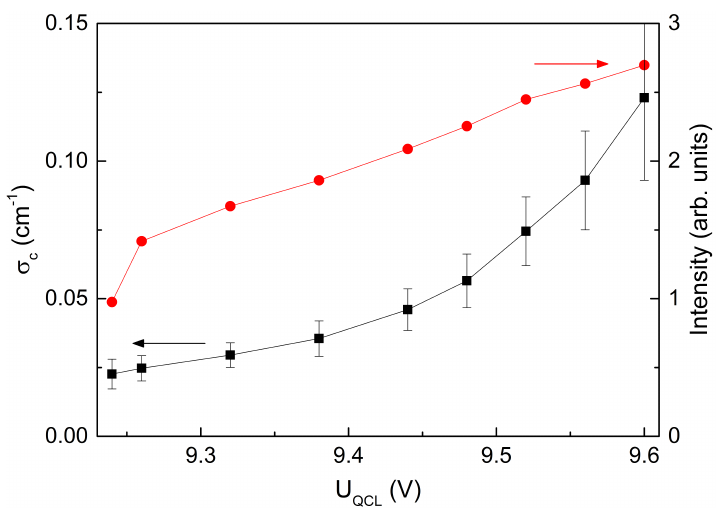
Figure 7. Broadening parameter σ c and detected laser intensity at pulse channel #400 of the current ramp as a function of the QC laser voltage U QCL . The broadening parameters have been determined from the Ge etalon transmission spectra as described in the text, whereas the intensity is obtained from the N 2 gas reference